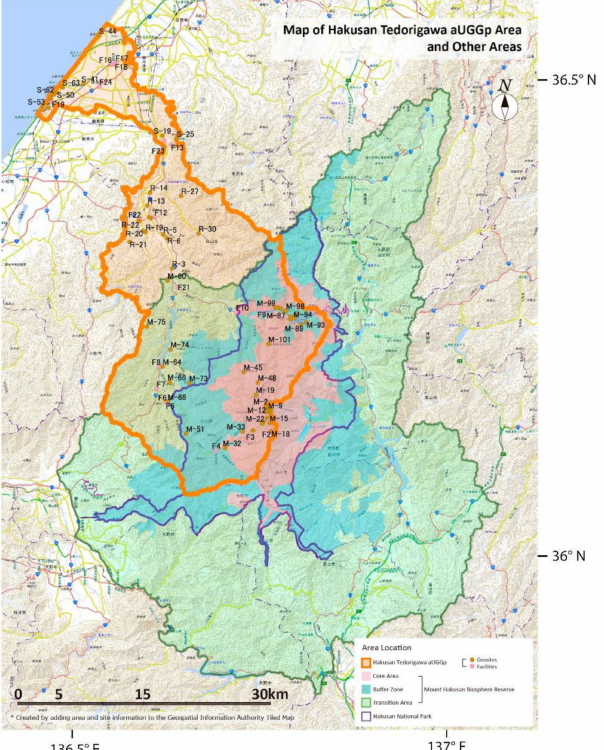
Figure 5. Overlapping territories between the Mount Hakusan Biosphere Reserve (green line) and the aspiring UNESCO Global Geopark MHTGP (orange line). Capital letters with numbers show geosites. Map provided by MHTGP Promotion